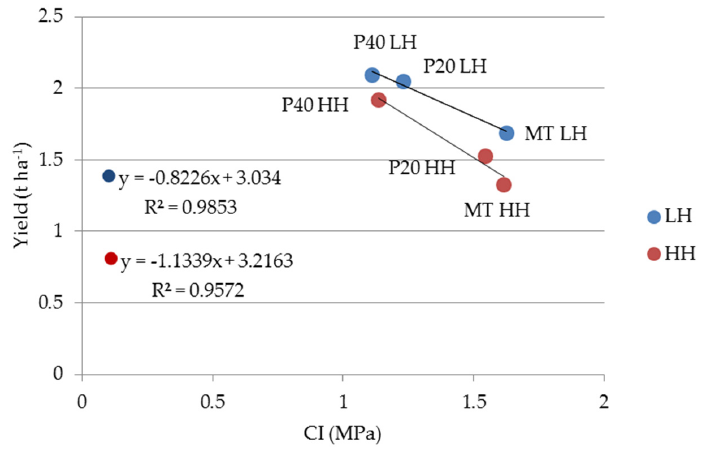
Figure 6. Relationships between grain yield and soil penetration resistance for low (LH) and high (HH) soil water content ( p ≤ 0.01).